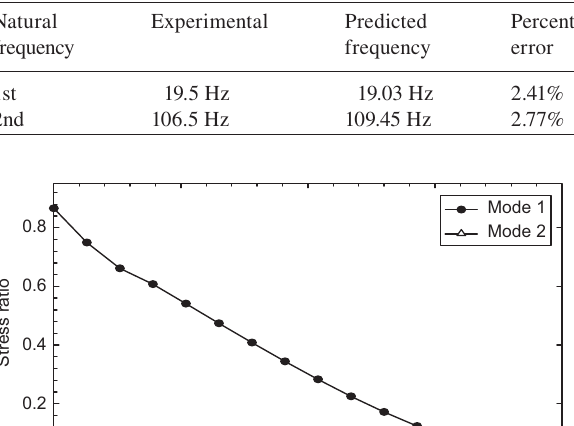
Table 2 Comparison of experimental and predicted natural